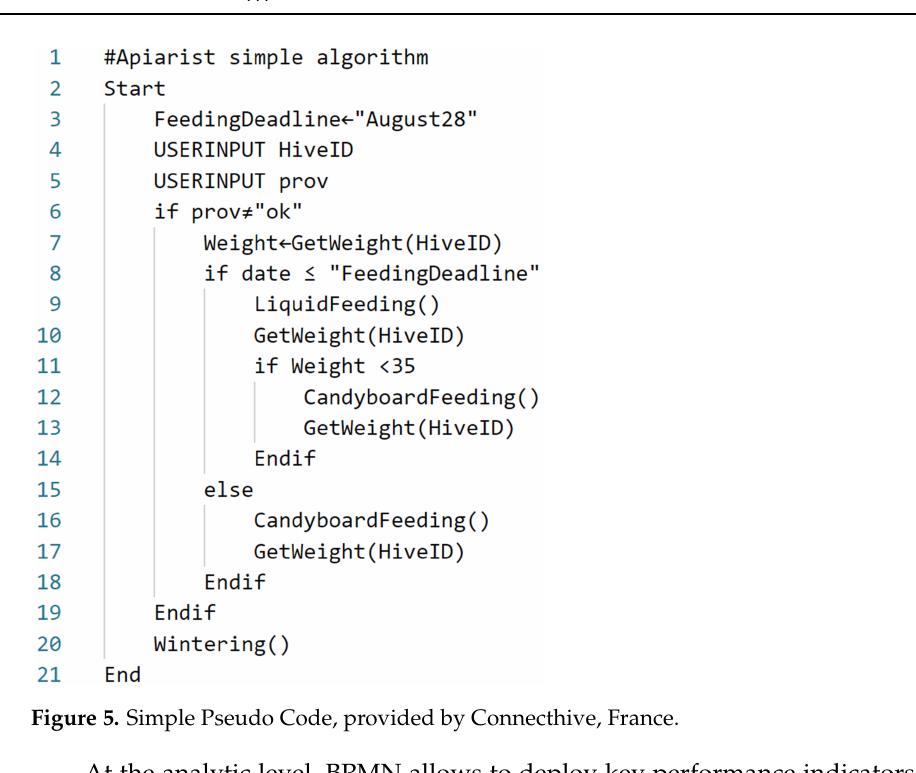
Table 3. Extract from the beekeeping best practices Excel file.